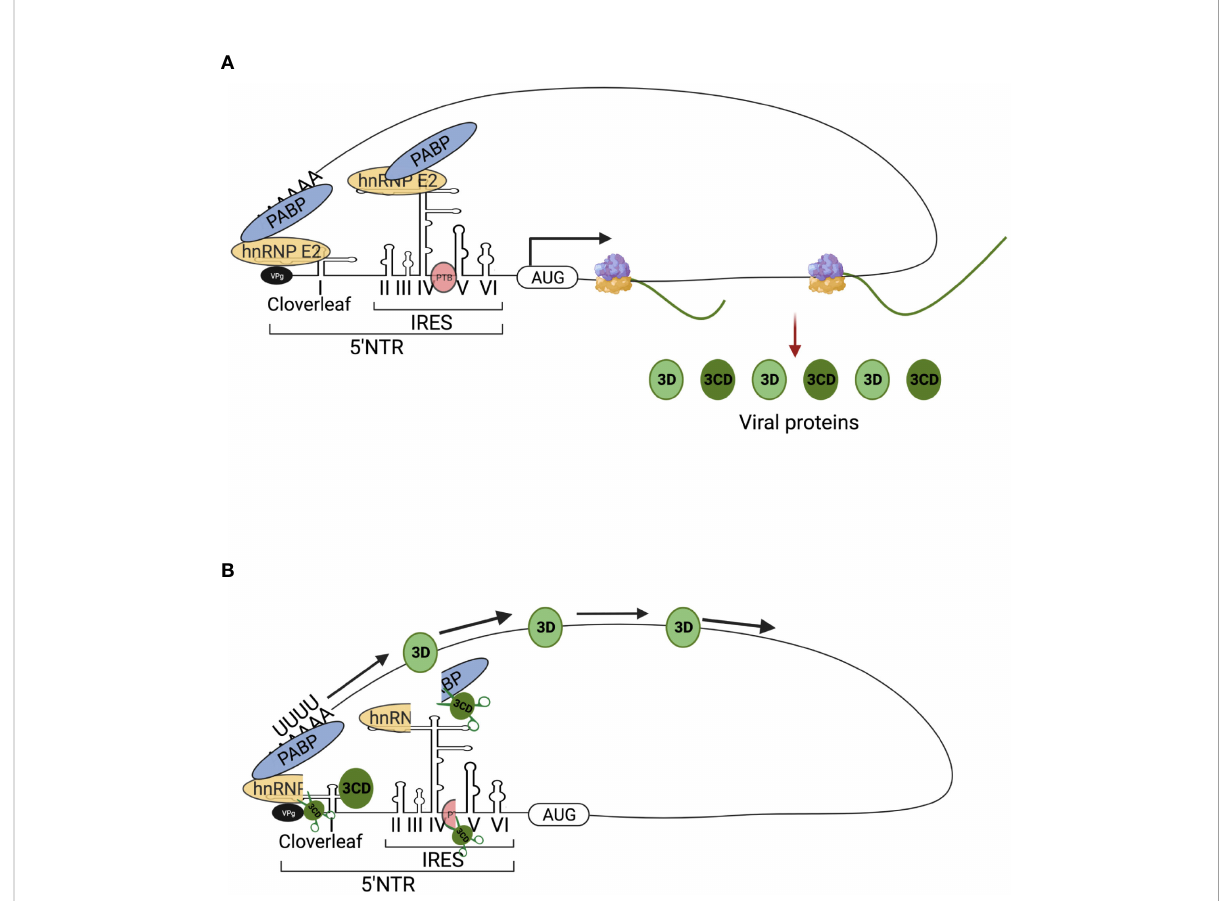
FIGURE 3 Schematic fi gures of involvement of hnRNP E (PCBP) in poliovirus (PV) translation and replication. The viral replication proteins may repress translation and switch to viral RNA synthesis, where hnRNP E is involved in the two roles of PV translation and replication. (A) PV translation: Full-length hnRNP E2 (PCBP 2) binds to stem-loop IV of IRES, which is necessary for cap-independent translation of the PV genome. The translation produces viral proteins, such as 3C/CD protease, which are required for subsequent switching of translation to replication. (B) Switching of translation to replication: The 3C/CD proteases cleavage hnRNP E2 (PCBP 2) and PTB, resulting in translation inhibition and template clearance from ribosomes. The cleaved hnRNP E2 (PCBP 2) binds to stem-loop I and forms a functional ternary complex with 3CD viral proteinase, which permits the initiation of RNA replication. The image was created with